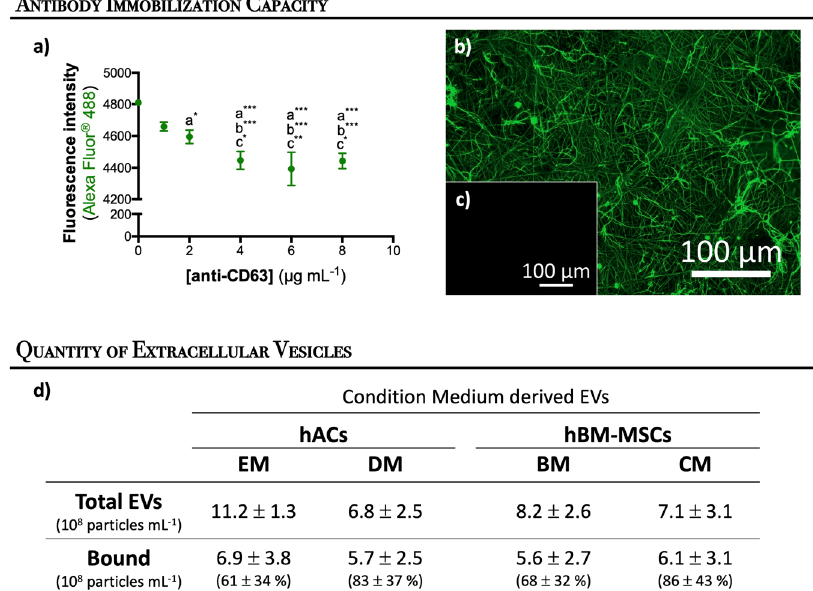
Fig. 1 Antibody immobilization and extracellular vesicle binding capacity. Immobilization capacity of anti-CD63 antibody at the surface of activated and functionalized nano fi brous substrates ( a ). The data are represented as mean ± standard deviation and analyzed by one-way ANOVA test, followed by the Tukey ’ s HSD test (* p < 0.01; ** p < 0.001; *** p < 0.0001): a denotes signi fi cant differences compared to concentration 0 μ g mL − 1 ; b denotes signi fi cant differences compared to concentration 1 μ g mL − 1 , and c denotes signi fi cant differences compared to concentration 2 μ g mL − 1 . Spatial distribution of anti-CD63 immobilized at the surface of activated and functionalized nano fi brous substrates at 4 μ g mL − 1 ( b ). The negative control sample was not incubated with the primary antibody ( c ). Quanti fi cation of extracellular vesicles derived from hACs and hBM-MSCs and bound to the biofunctional nano fi brous system ( d